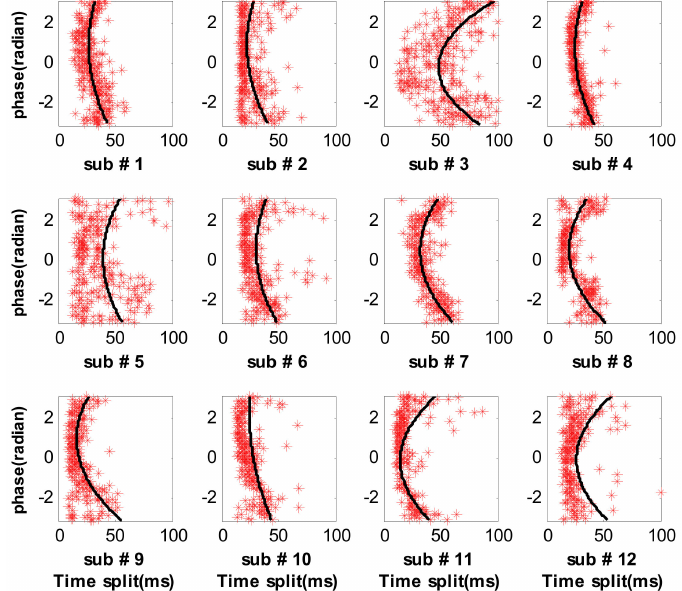
Figure 12. Measured respiratory splits of the 12 subjects by the HVD method.